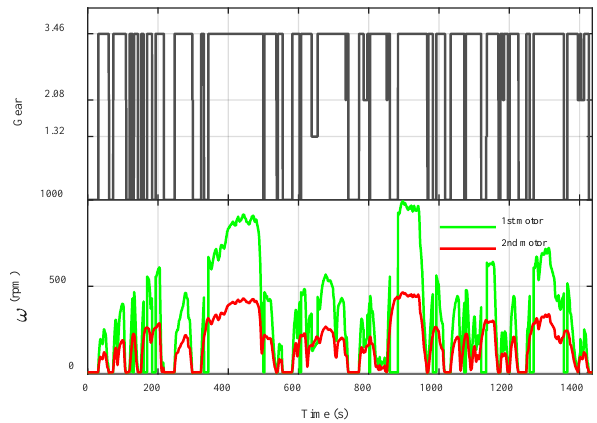
Figure 9. Gear shifting with the modified power-sharing strategy.